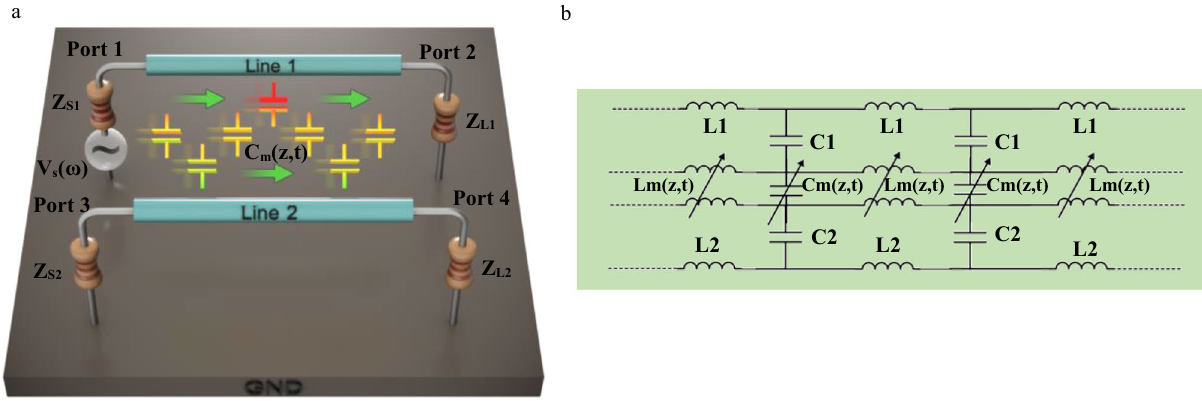
Figure 1. (a ) Conceptual representation of coupled transmission line with space–time modulated mutual capacitance and mutual inductance. For the sake of clarity the modulated mutual inductance is not shown here. ( b ) Circuit model for a coupled transmission line with space–time modulated mutual capacitance and